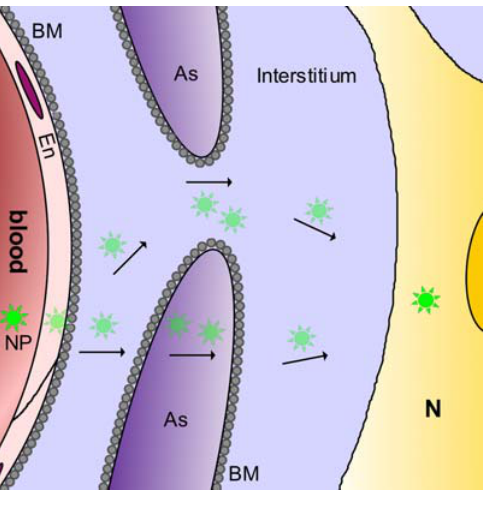
Figure 3. Shows possible transbarrier transport paths for nanoparticles across the barriers between the blood and the central nervous tissue. Nanoparticles (NP, green stars) applied in the blood could cross the endothelial layer (En) and the subendothelial basement membrane (BM), and pass through the gaps between two astroglial endfeet (interstitium). Alternatively, they could be transcytosed across the astroglial endfeet (As), to reach the central neurons